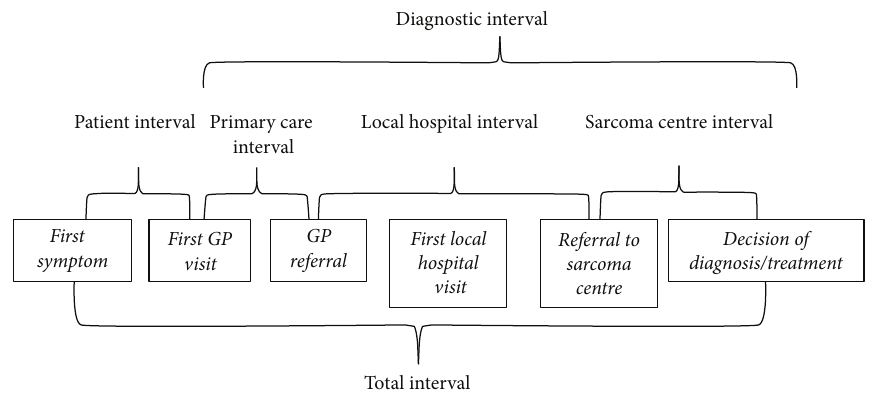
Figure 1: Overview of time points and calculated time intervals